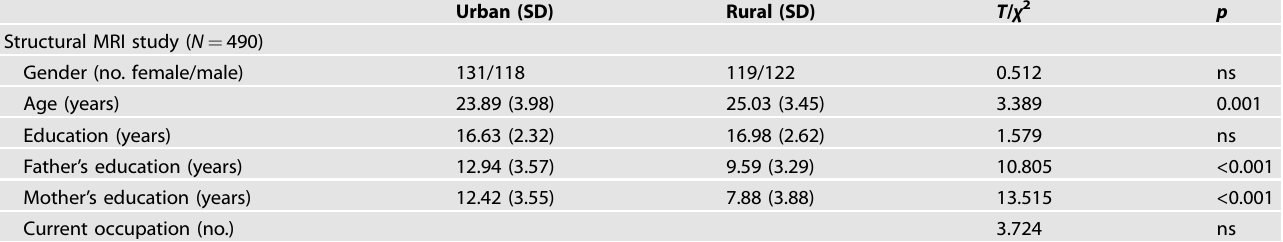
Table 1. Demographic and behavioral characteristics of subjects.